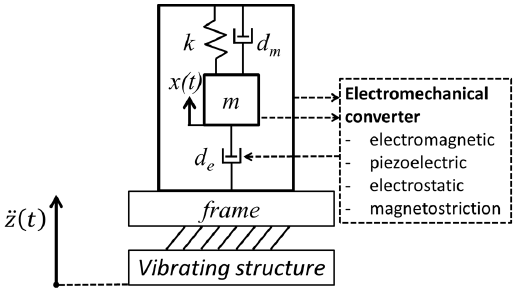
Figure 5. Scheme of vibration energy harvester [58].